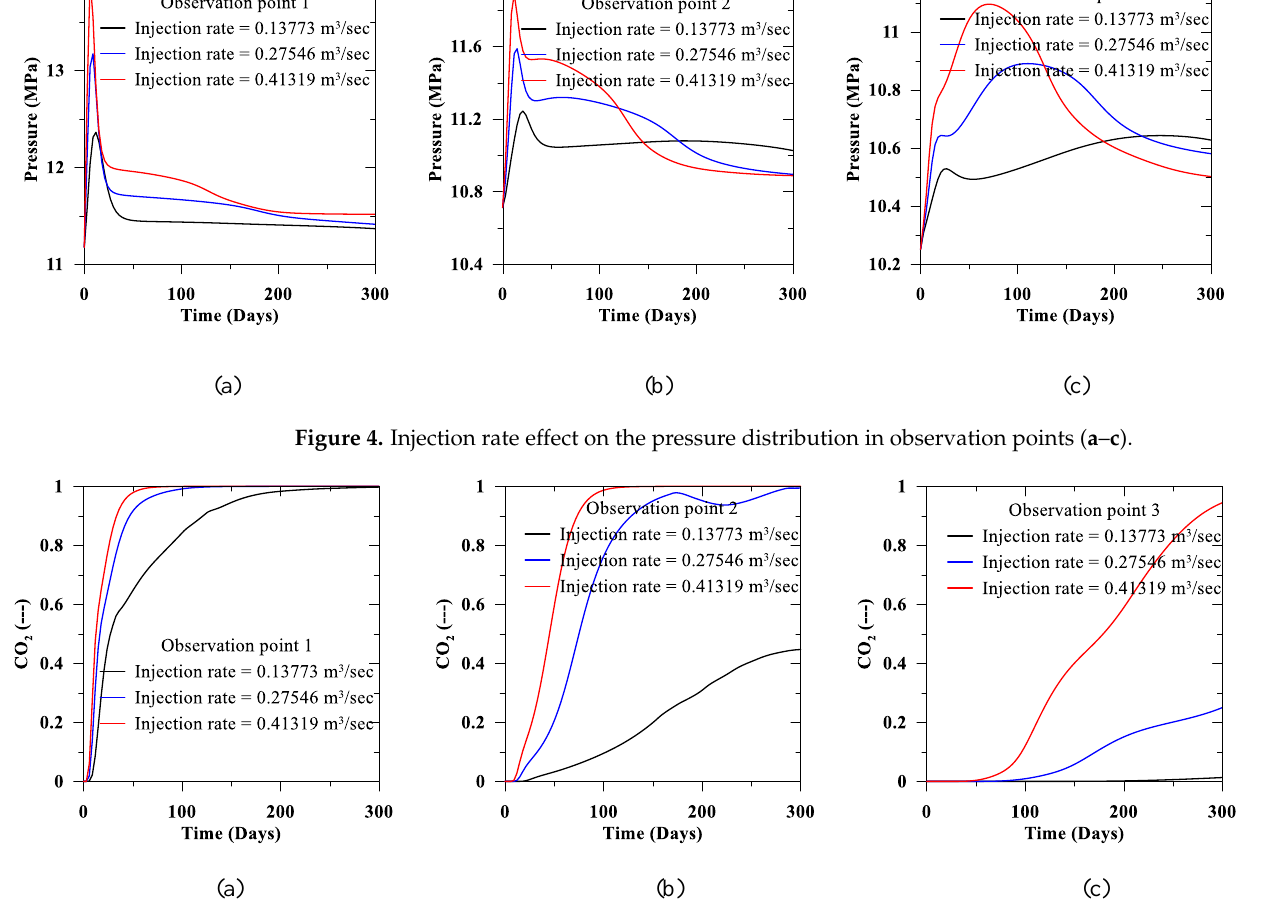
Figure 5. Injection rate effect on CO 2 mole fraction distribution in observation points ( a – c ).